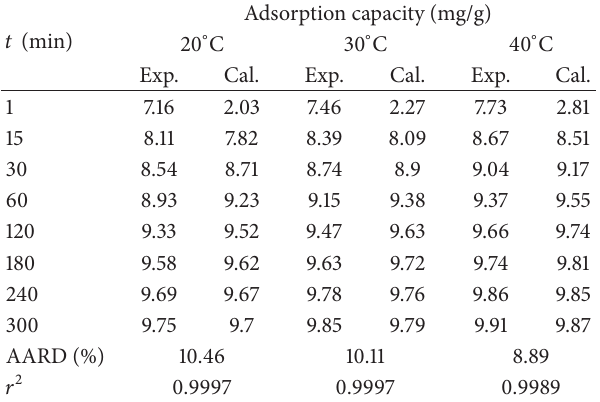
Table 5: Experimental and calculated lead adsorption capacity of irradiated mineral at different temperatures (150kGy, 𝐶 0 = 100 mg/L, 𝑤 = 1 g, and 𝑉 = 0.1 L).